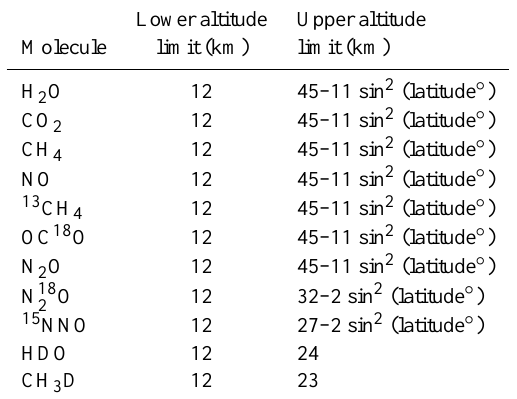
Table 2. Interferers in the v3.0 ACE-FTS carbonyl fluoride